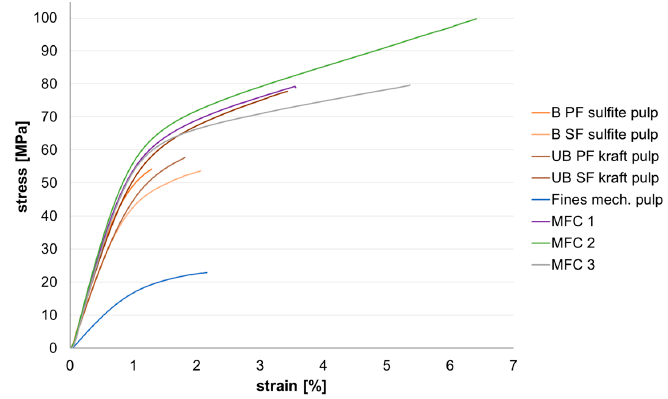
Figure 8. Stress-strain curves of fines and MFC sheets ( v = 5 mm/min, a free clamping length: 50 mm, strip width: 15 mm).